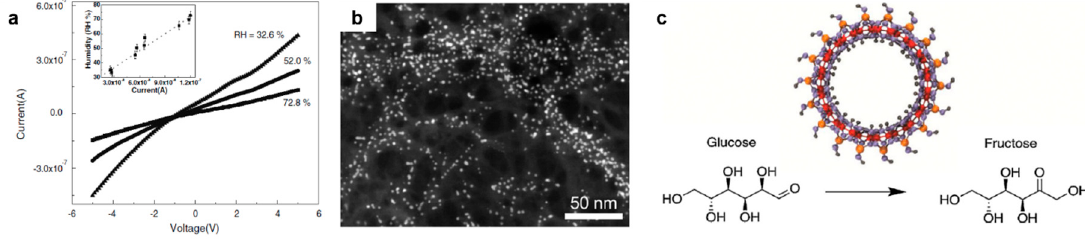
Figure 8. Examples of nanodevices and catalysis applications using imogolite nanotubes ( a ) I-V curves of an INT film measured in a FET device at different relative humilities for water sensoring. Adapted with permission from [165]. ( b ) Stabilization of modified gold nanoparticles on outer surface of INTs. Adapted with permissions from [167]. ( c ) Selective isomerization of glucose to fructose by INTs. Adapted with permissions from [78].